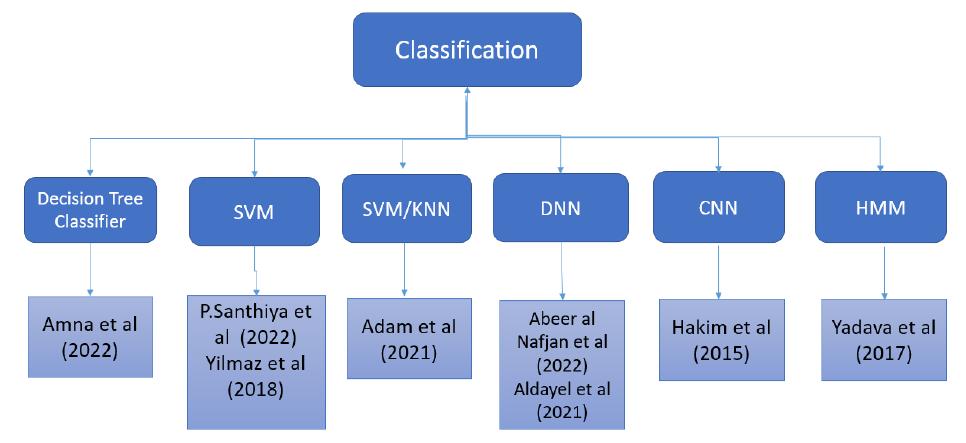
Figure 3. Classification of EEG signals in the